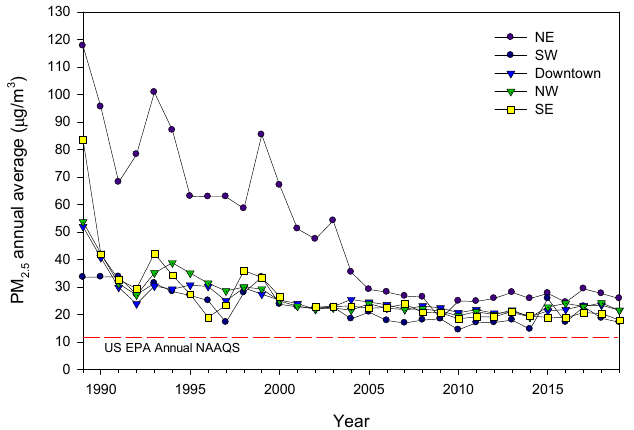
Figure 1. Time series trends showing annual mean 24 h PM 2.5 concentrations, averaged over 3 years, for five representative MMC monitoring stations from 1990 to April 2020 and their comparison with the respective annual US EPA NAAQS. Annual means from the years before 2004 were estimated from available information of PM 10 since 1990 and the mean slope of the correlation PM 10 vs. PM 2.5 between 2004 and 2007. Data from: http://www.aire.cdmx.gob.mx/default.php# (accessed on 4 June 2022).